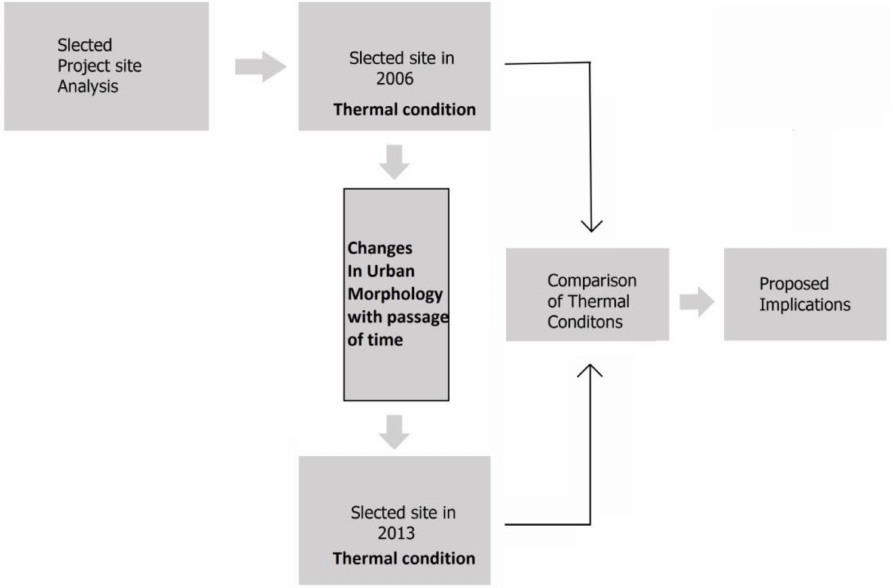
Figure 2. Flow diagram of the study